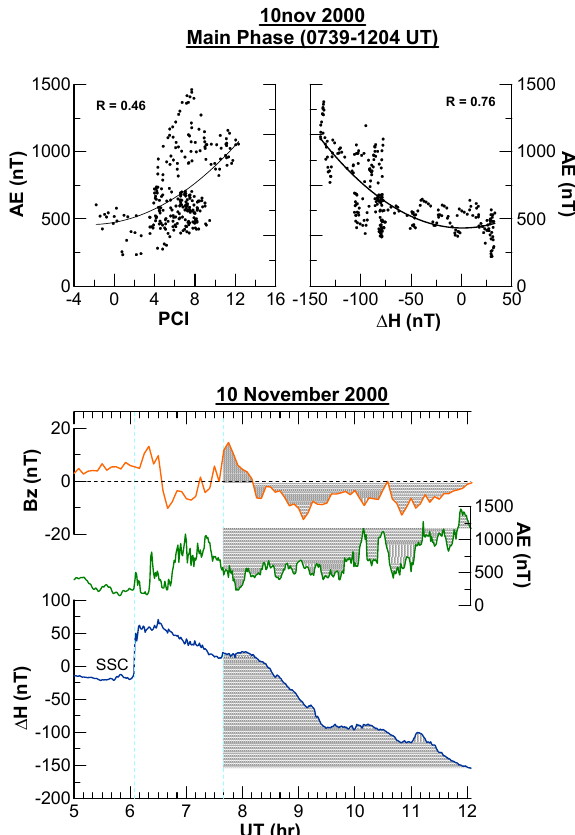
Fig. 11. Upper panel displays the correlations of polar cap magnetic activity ( PC ) index and low-latitude geomagnetic field 1H ABG with auroral electrojet ( AE ) index for 10 November 200 for “ T 1” (07:39–12:04 UT) period. Bottom panel shows the variations of AE index and 1H ABG with corresponding IMF B z